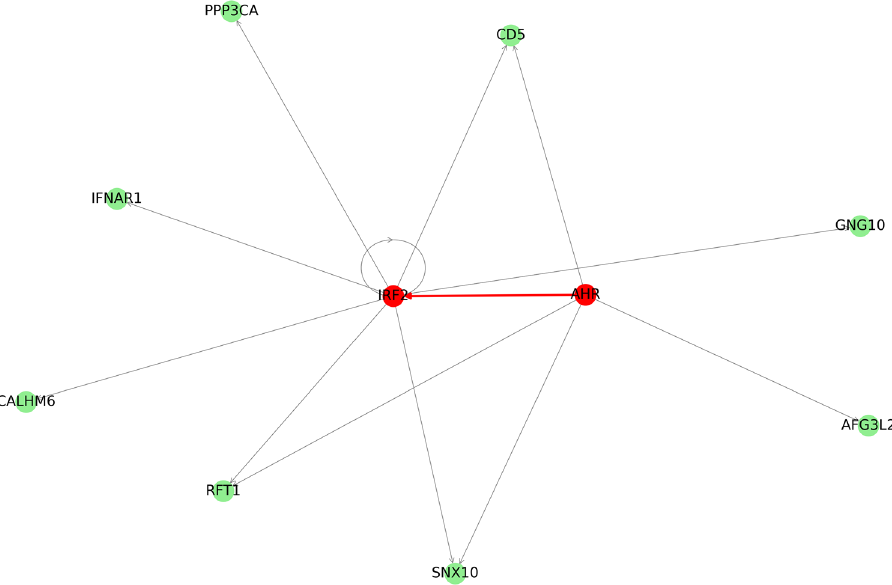
Figure 4. Graph of transcription transcription factor regulation pathways among DE-genes (green) and of RFI QTL gene (red). Interactions between transcription factors highlighted by red